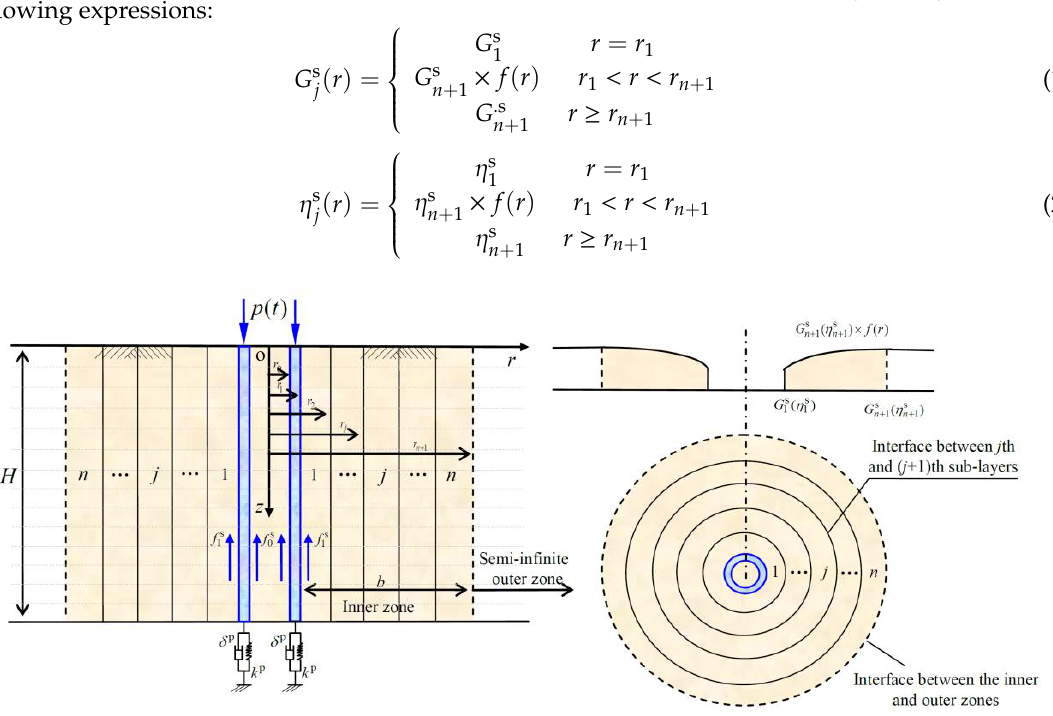
Figure 1. The mechanical computational model.